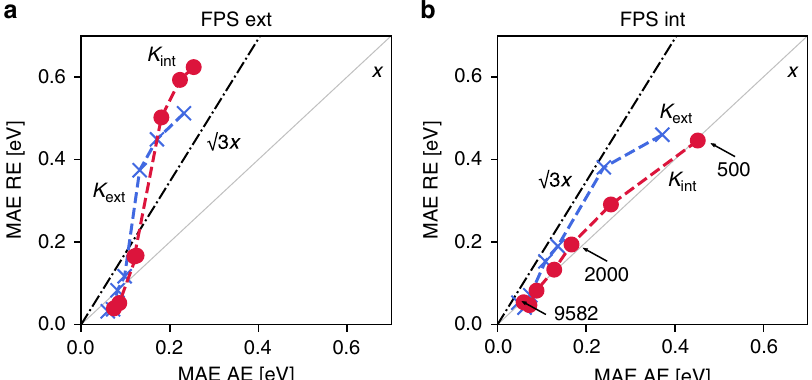
Fig. 6 Correlation of mean absolute errors (MAE) for AE and RE prediction. a Correlation plot for the extensive FPS training set using the extensive and intensive kernels and DFT geometries. b Correlation plot for the intensive FPS training set using the extensive and intensive kernels and DFT geometries. Multiple points for each model represent the different training set sizes shown in Fig. 4 (indicated in ( b )), with smaller AE errors corresponding to larger training